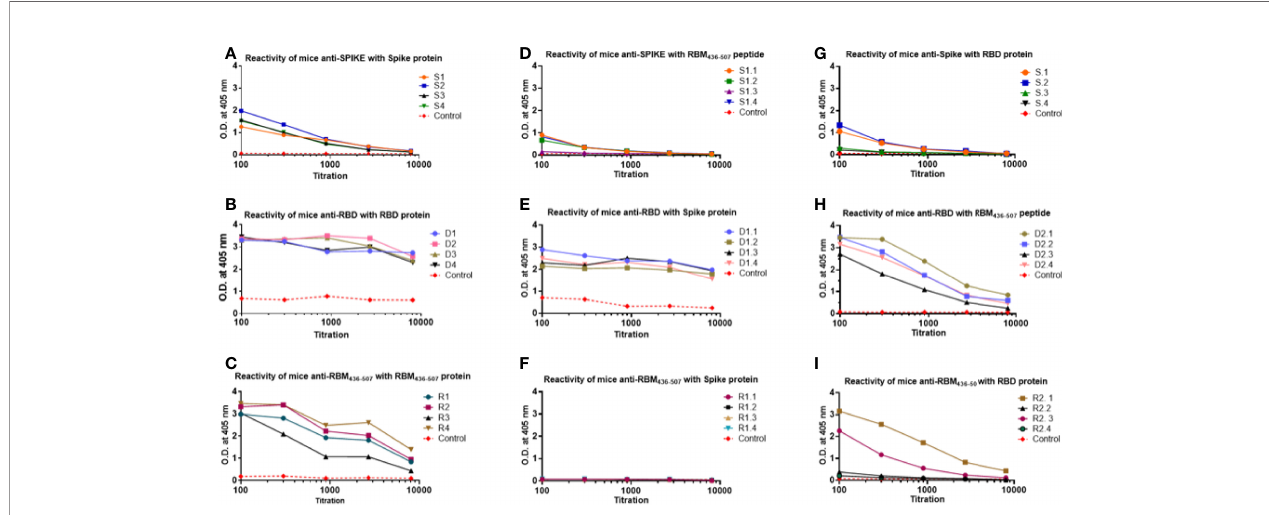
FIGURE 3 | Homologous and cross reactivity of the S, RBD and RBM 436-507 antigens with antibodies elicited upon mice immunization. (A – C) show reactivity of anti- S, anti-RBD and anti-RBM